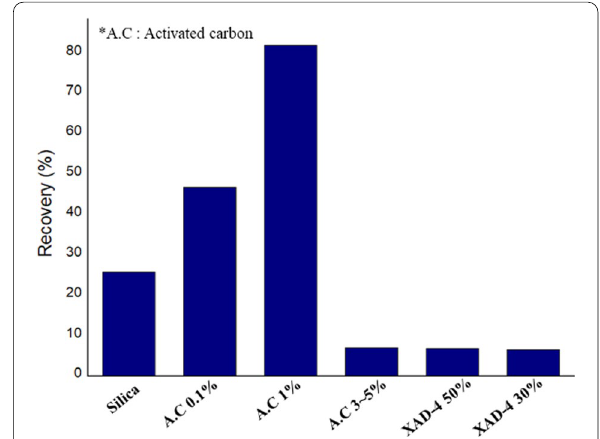
Fig. 4 ZnDDP absorption efficiency according to activated carbon content